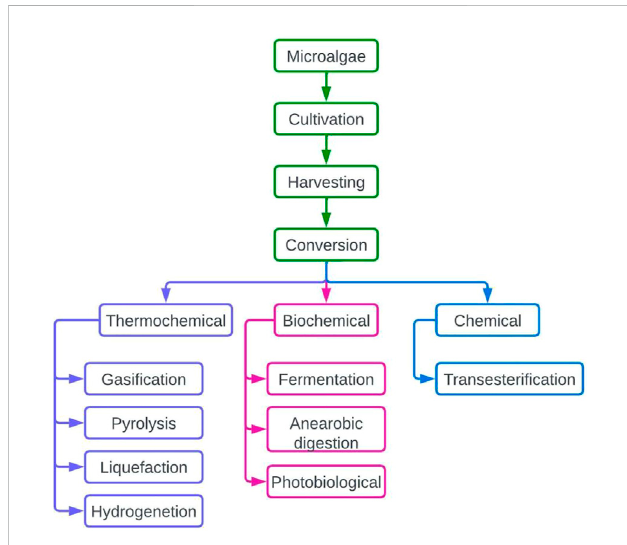
FIGURE 1 Various conversion technologies for biofuel production, modi fi ed from (Suali and Sarbatly,